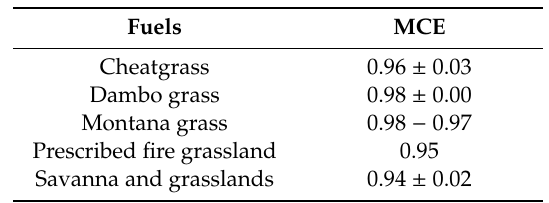
Table 1. Cheatgrass modified combustion e ffi ciency (MCE) is shown with previously reported MCE values for a prescribed grassland fire [50], open laboratory combustion of Dambo and Montana grass [7], and savanna and grasslands fires [51,52].